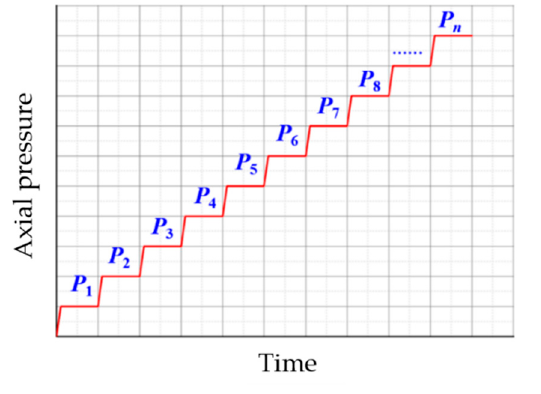
Figure 6. Loading path in the tests.